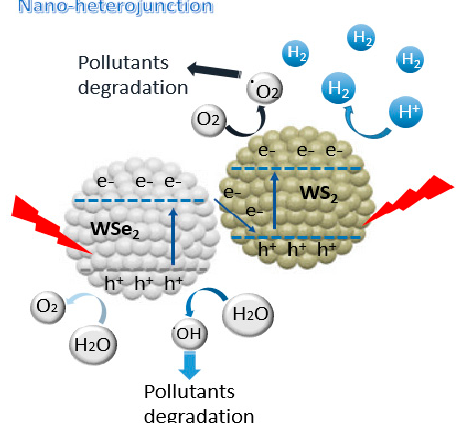
Figure 7. Schematic diagram of the proposed heterojunction photoelectron mechanism of the WSSe photocatalytic system under visible light illumination.